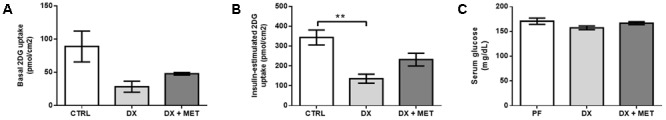
2-DG uptake in adipocytes extracted from the subcutaneous AT under basal conditions (A) and when stimulated by insulin (B), and serum glucose level (C): mice were injected with doxorubicin hydrochloride (DX) or saline (CTRL) i.p. twice a week for 2 weeks, and a subset received a daily oral gavage of metformin (DX + MET). Data are presented as means ± SD. n = 3–5 (A,B)
n = 6 (C). The groups were compared using one-way ANOVA followed by Bonferroni posttests ∗∗p ≤ 0.005.